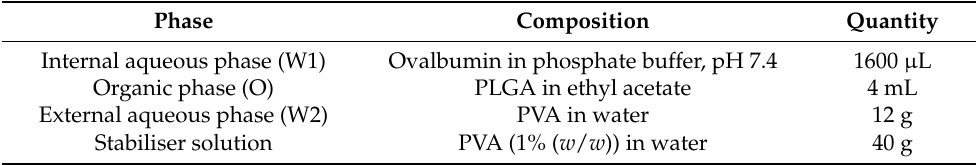
Table 1. Constant composition of double emulsion; concentrations